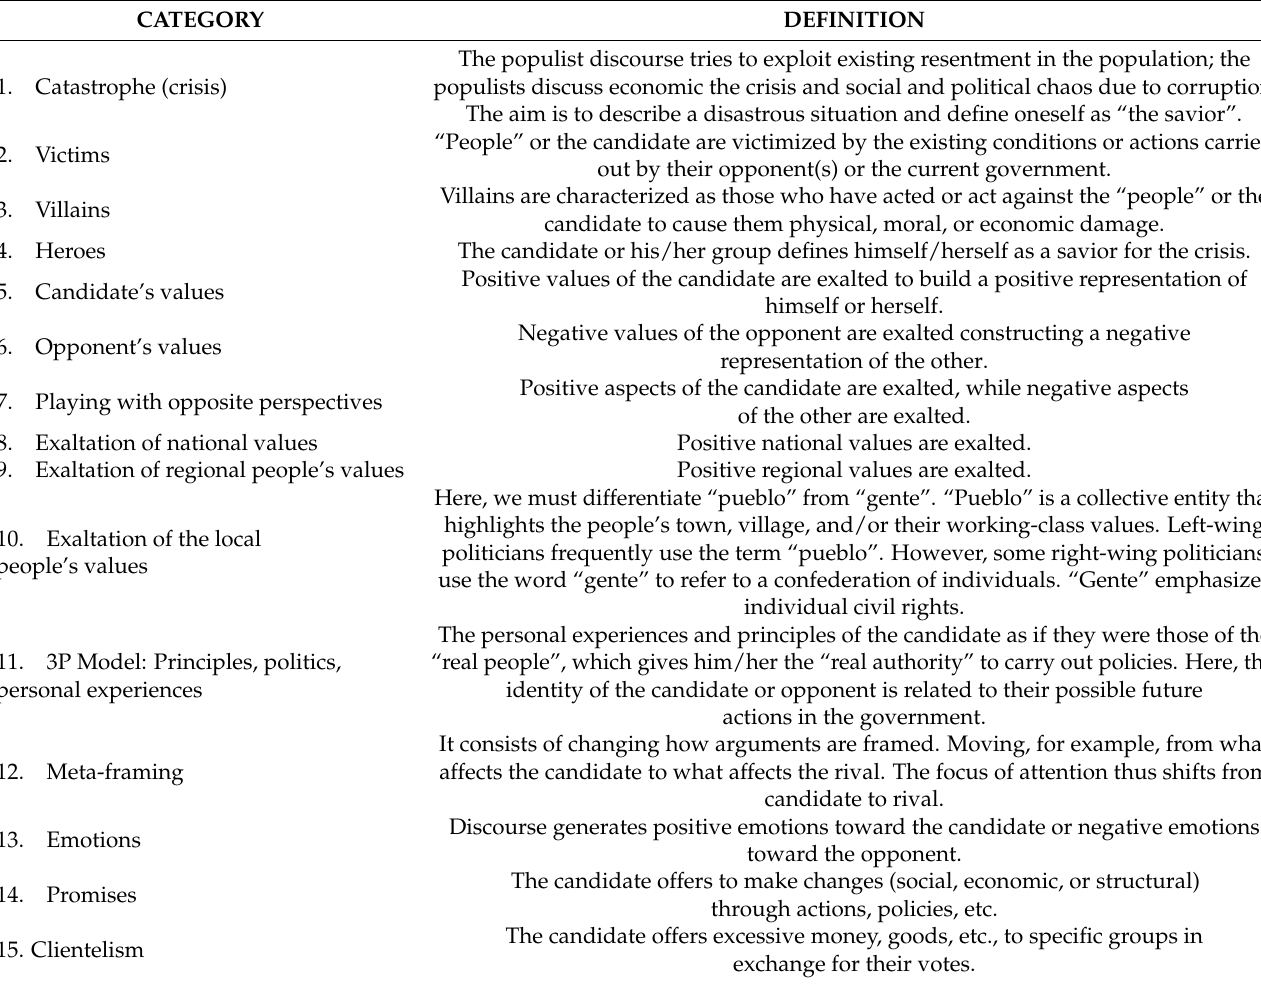
Table 2. Categories and